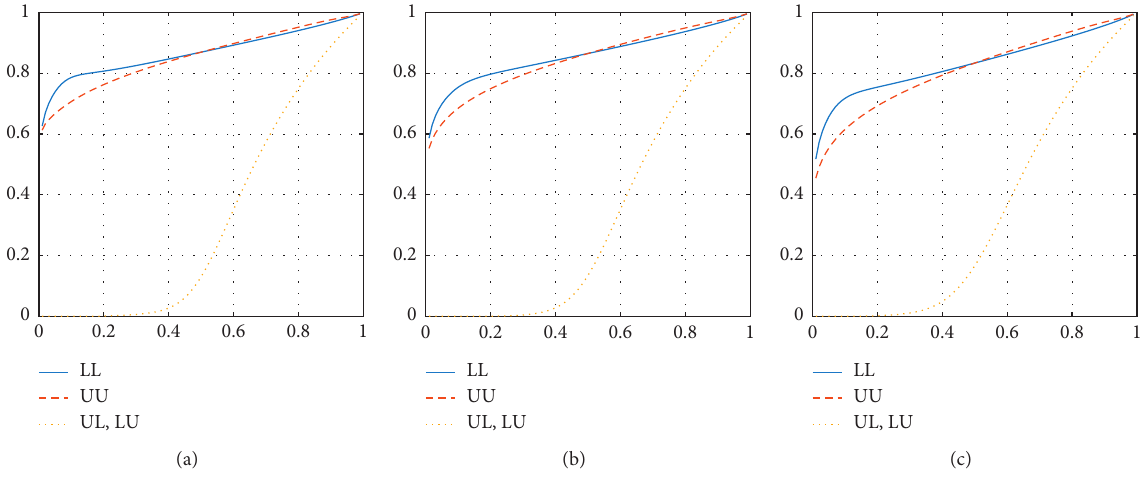
Figure 15: QD curves of bivariate CCC-NCCN copula model. (a) HSI-CEI. (b) HSI-CCI. (c)